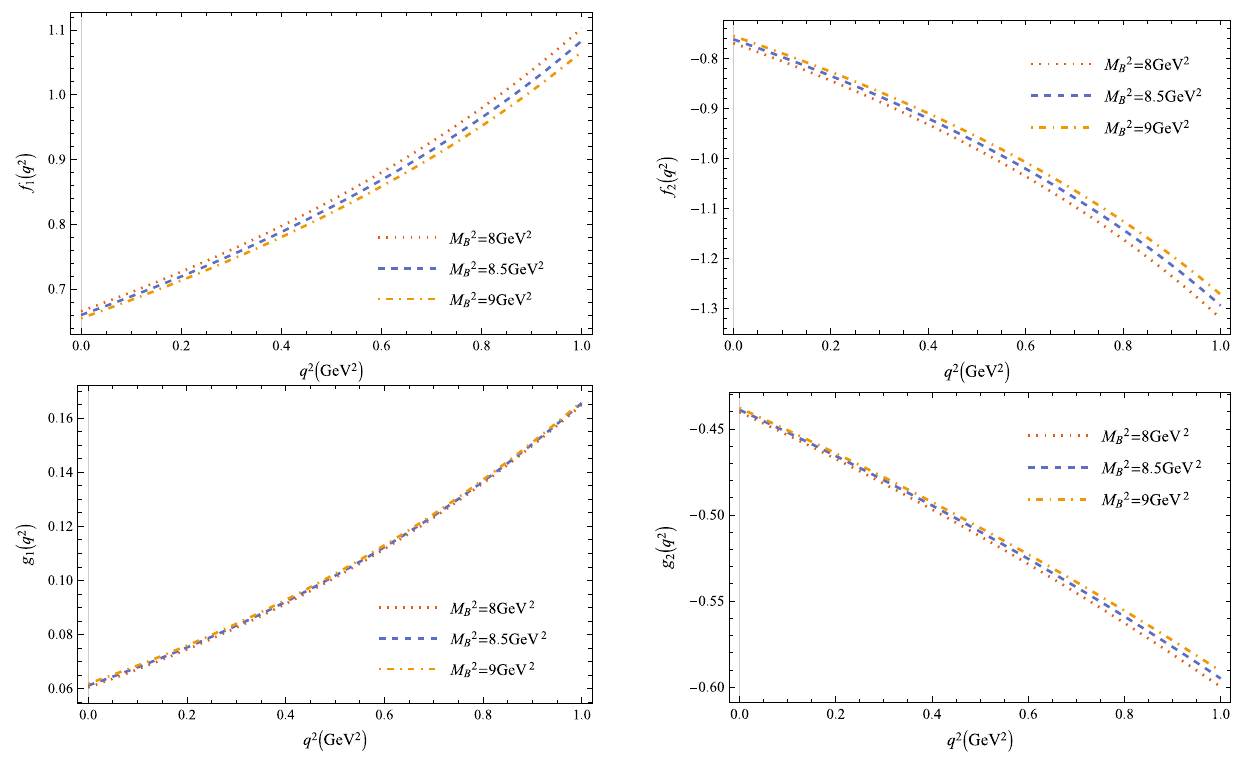
Fig. 2 The form factors f i ( i = 1 , 2 ) and g i ( i = 1 , 2 ) vary from zero momentum transfer square to q 2 = 1 GeV 2